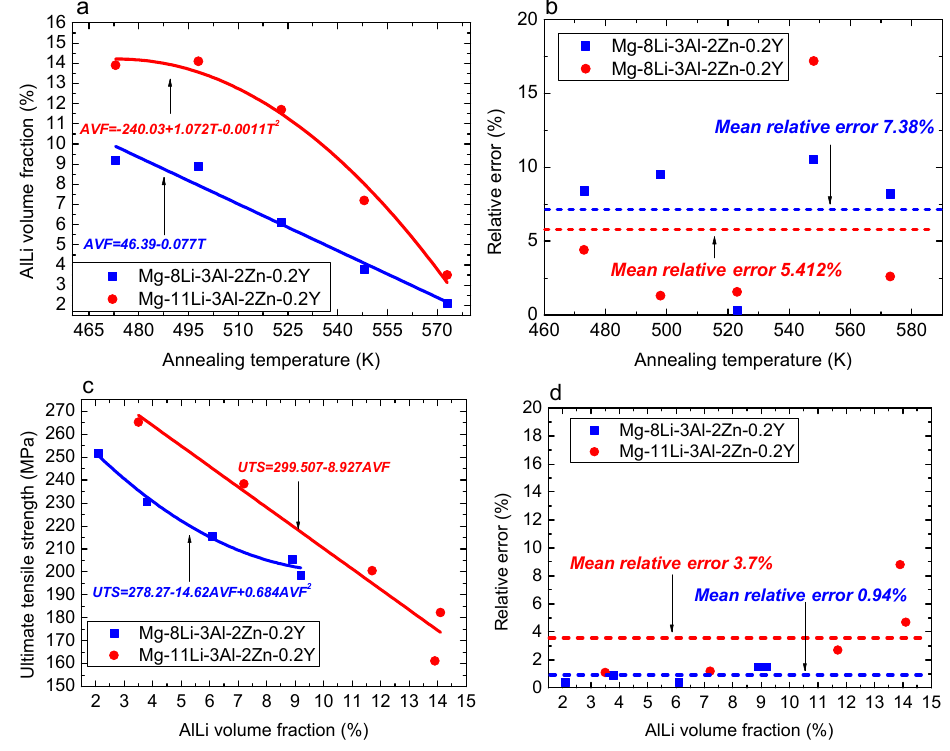
Figure 12. Fitting relationship results: ( a ) AlLi volume fraction on annealing temperature; ( b ) fitting accuracy of Equation (10); ( c ) ultimate tensile strength on AlLi volume fraction; ( d ) fitting accuracy of Equation (11). Materials 2017 , 10 , 1167